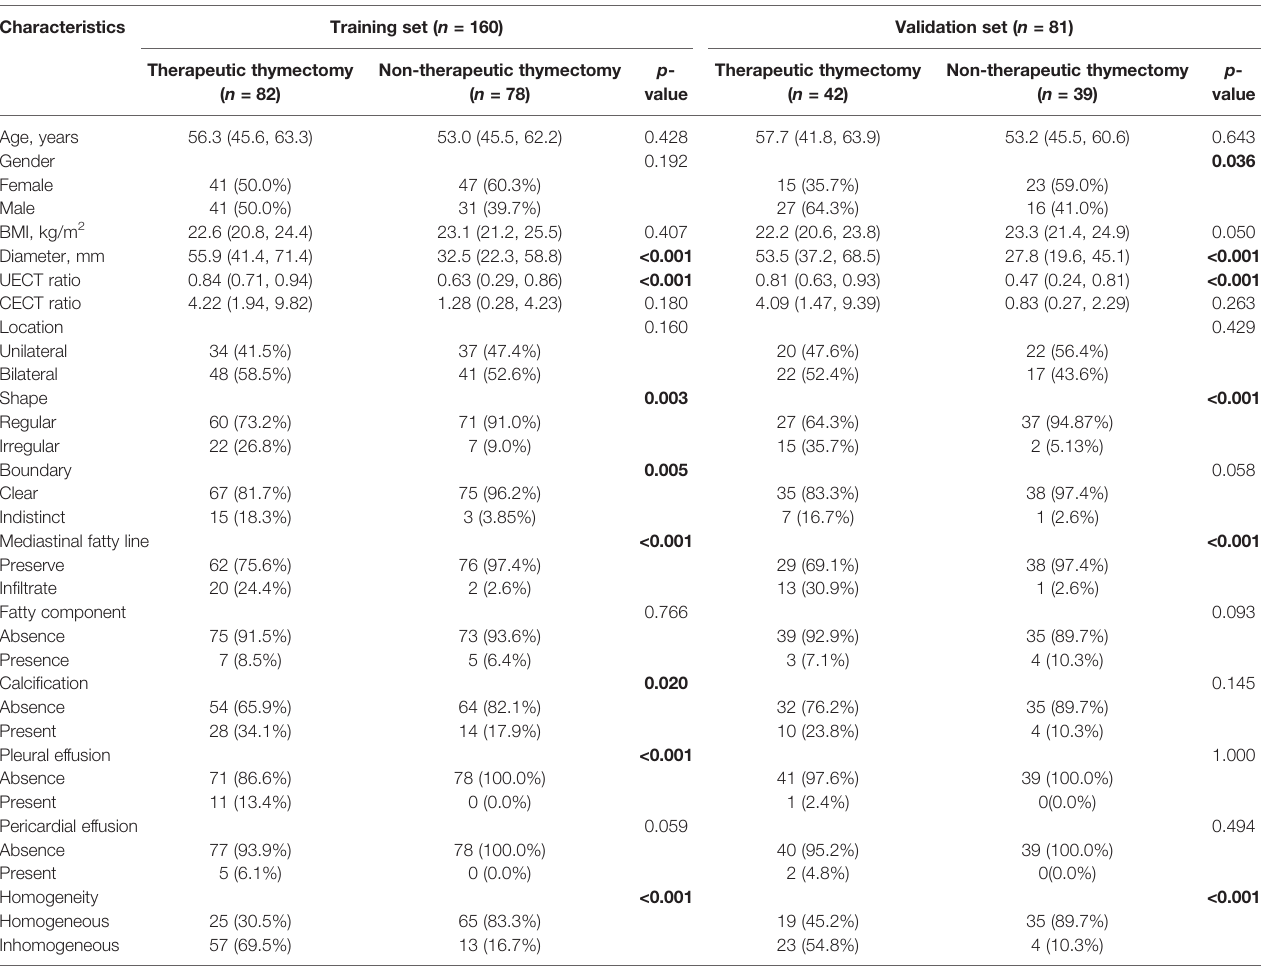
TABLE 3 | The clinical and radiographic features in the training and validation sets of CECT.